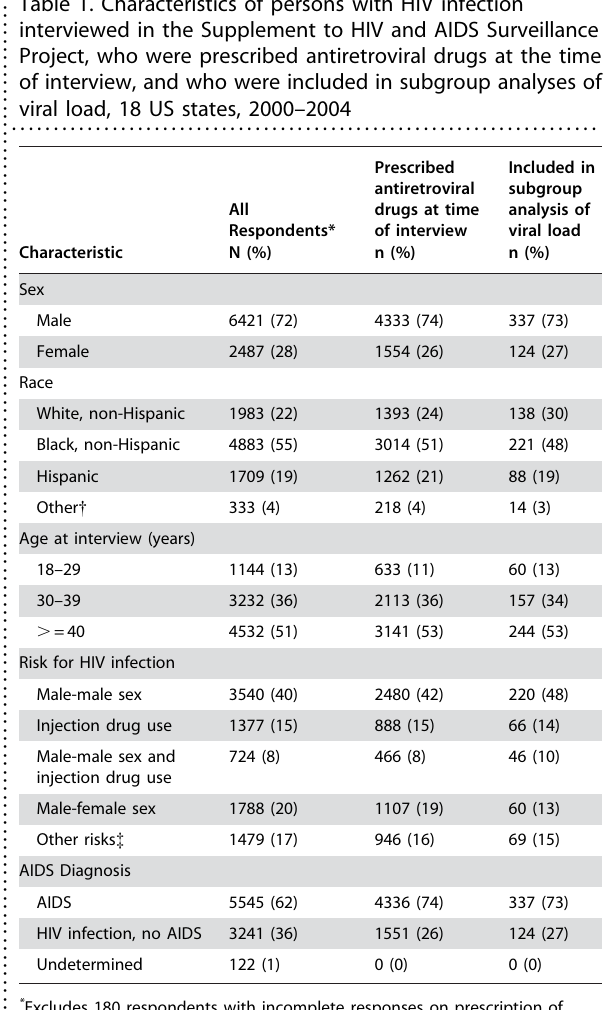
* Excludes 180 respondents with incomplete responses on prescription of antiretroviral therapy { Other races include non-Hispanic American Indian/Alaskan Native, non- Hispanic Asian/Pacific Islander, and persons reporting multiple